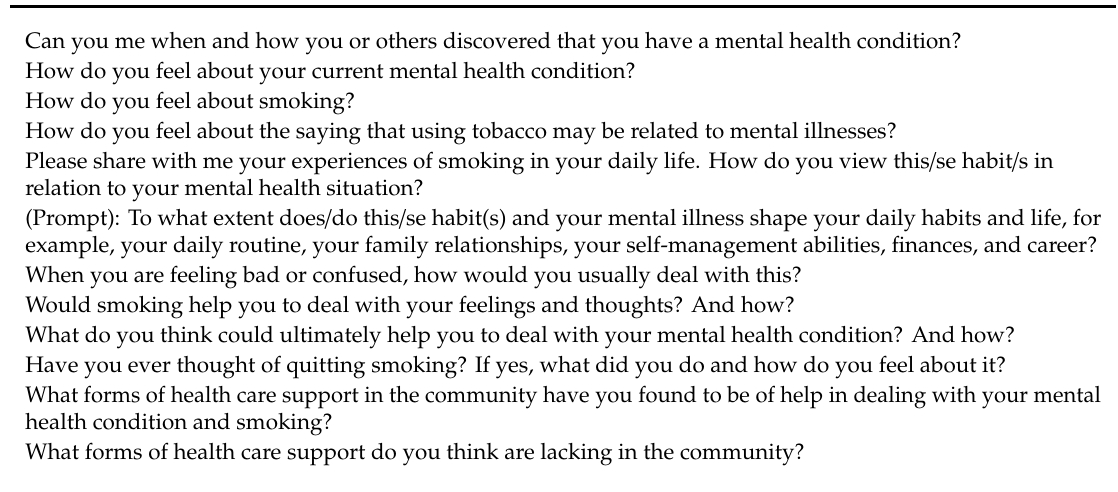
Table 1. Interview Guiding